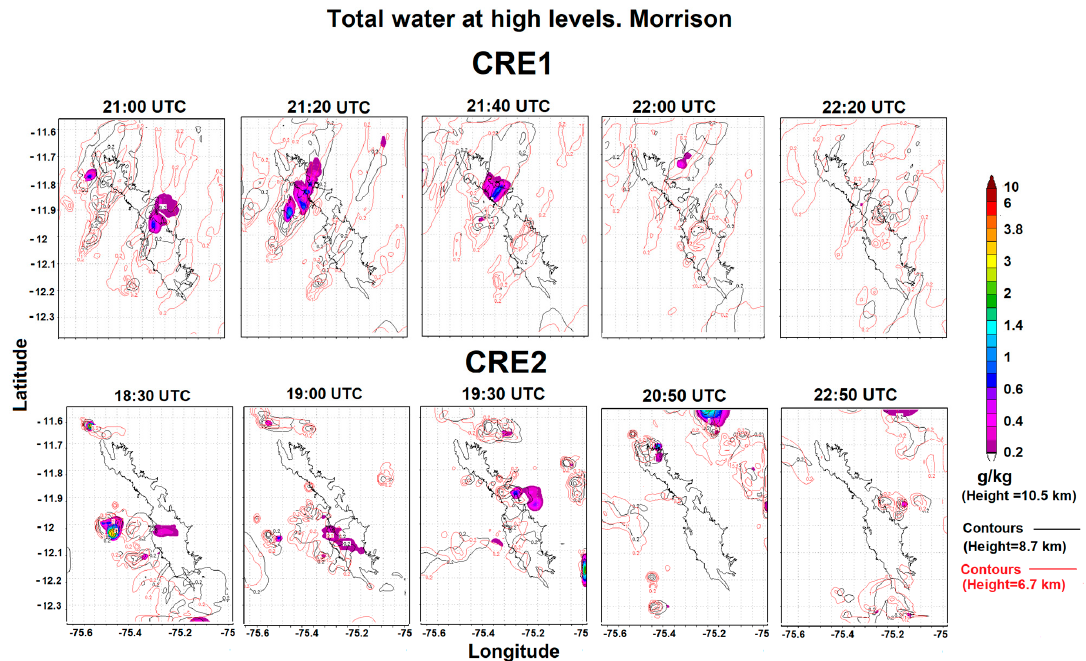
Figure 17. Horizontal cross sections of the total water mixing ratio at the WRF output levels of 6.7 km (red contour lines), 8.7 km (black contour lines), and 10.5 km (shaded), showing the cloud top positions.